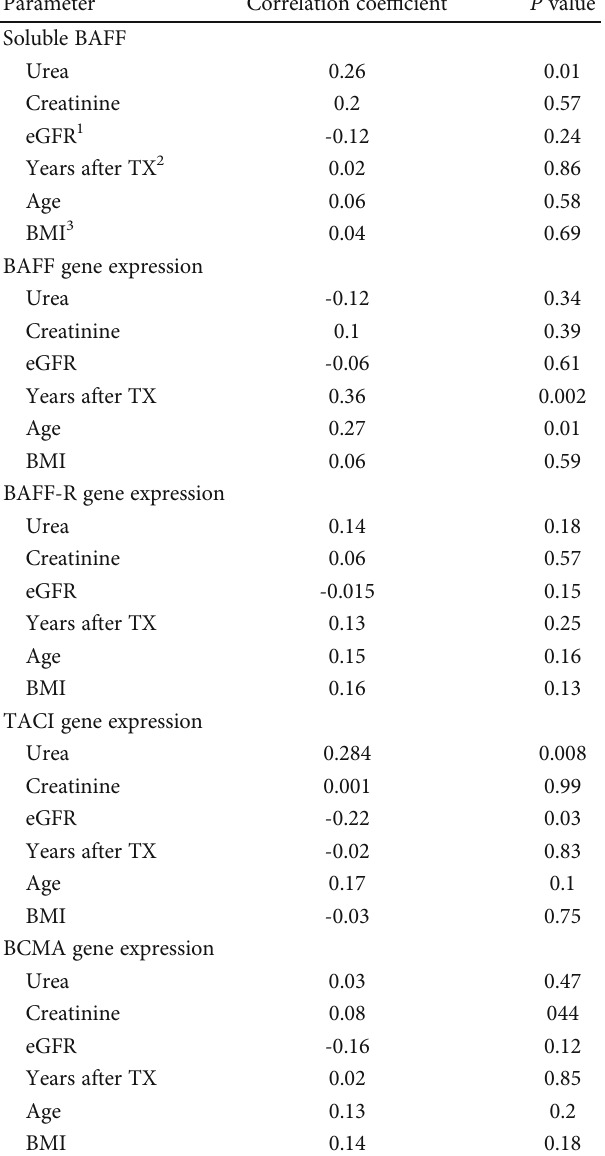
Table 5: Correlation of BAFF and its receptors with some demographic